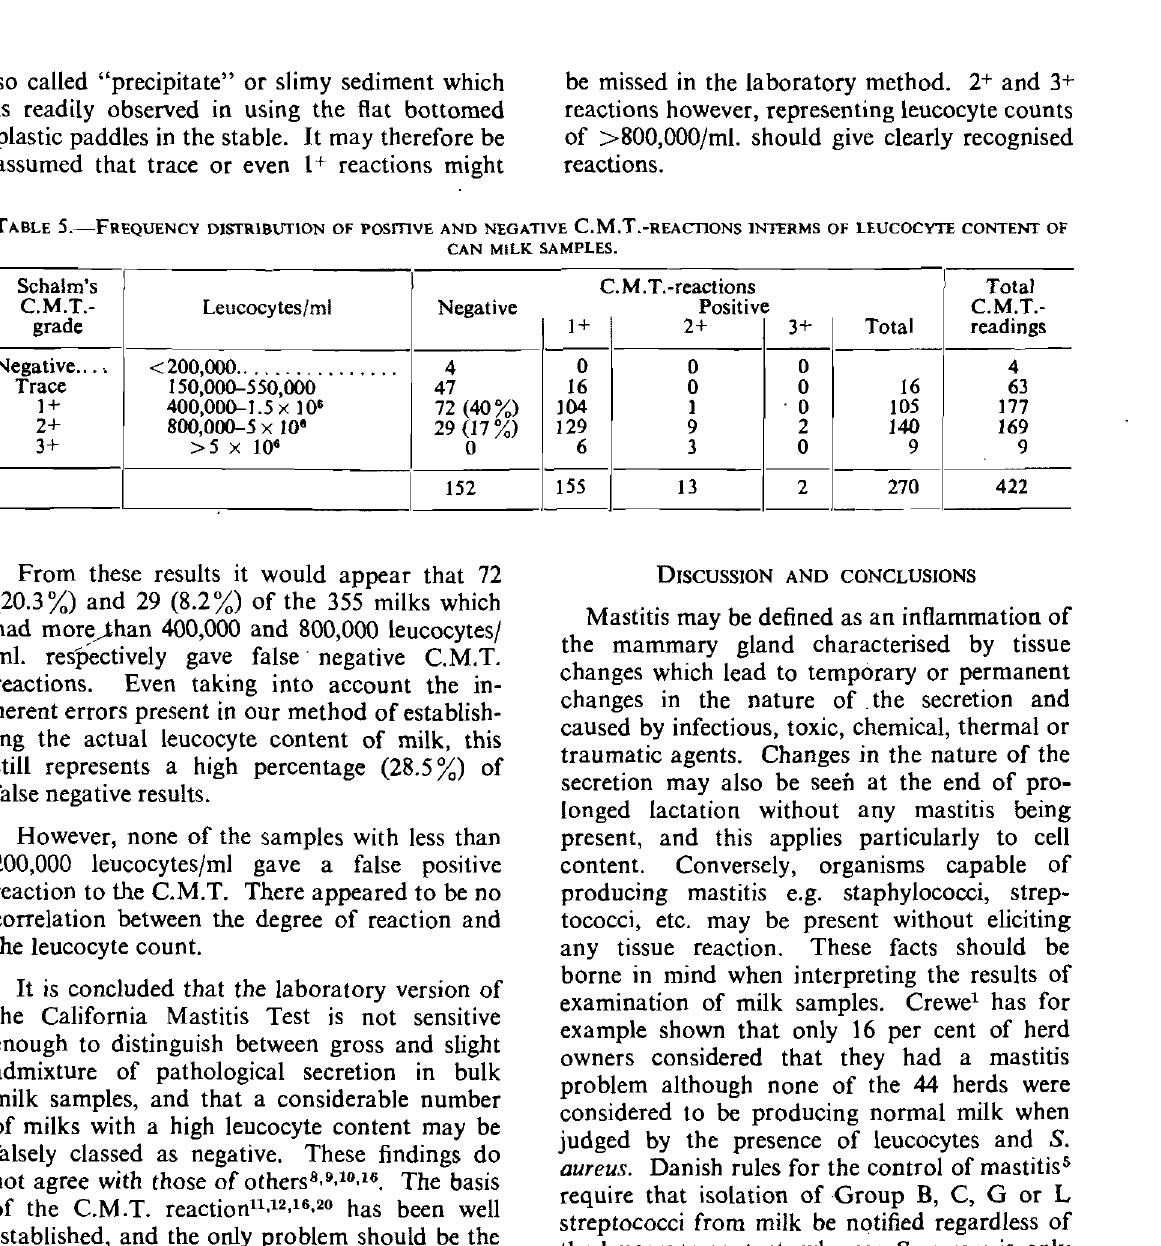
CAN MILK SAMPLES. I